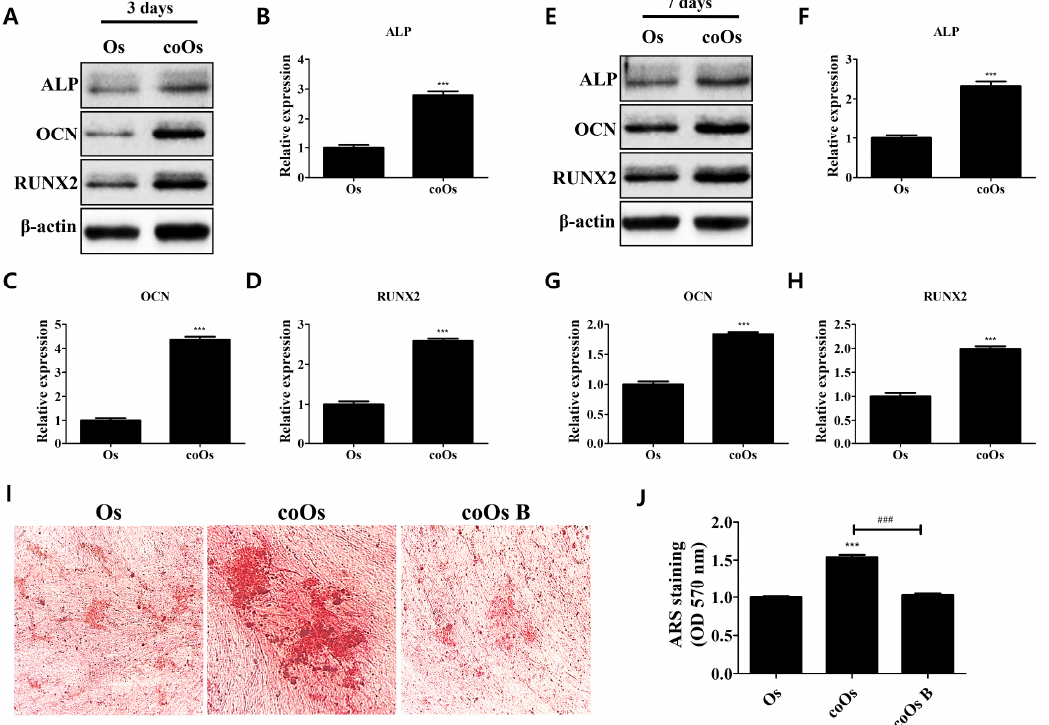
Figure 4. Effects of the PD-1/PD-L1 axis on osteogenic properties in osteoblasts cocultured with hADMSCs. ( A ) Expression levels of osteogenic marker proteins in monocultured or cocultured osteoblasts for 3 days. Relative expression levels of ( B ) ALP, ( C ) OCN, and ( D ) RUNX2 in cocultured osteoblasts for 3 days compared with monocultured osteoblasts. ( E ) Expression levels of osteogenic marker proteins in monocultured or cocultured osteoblasts for 7 days. Relative expression levels of ( F ) ALP, ( G ) OCN, and ( H ) RUNX2 in cocultured osteoblasts for 7 days compared with monocultured osteoblasts. N = 3 trials per sample and control. ( I ) Enhancement of matrix mineralization in cocultured osteoblasts and attenuation via inhibition of PD-1/PD-L1 interaction. ( J ) Stained calcium deposits were dissolved and quantified. N = 5 trials per sample and control. Data are presented as mean ± SEM. *** p < 0.001, compared with the Os group and ### p < 0.001, compared with the coOs group. Os: osteoblasts; coOs: cocultured osteoblasts; B: BMS 202 (10 μ M).